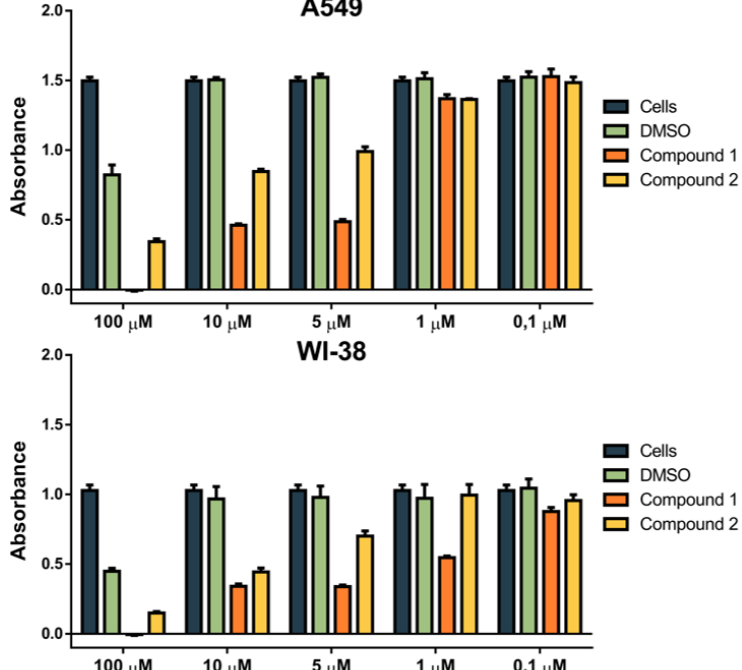
Figure 4. Cytotoxic assay of compounds 1 and 2 performed on A549 and WI-38 cell line. Measured absorbance (λ = 600 nm) directly correlates with cell survival. Cells with added DMSO in corresponding concentration represent control (note toxicity of DMSO at 100 µM but negligible effects at lower conc.). Data are presented as mean ± SD made in three replicates. The representative data of two independent experiments that yielded similar results are shown.